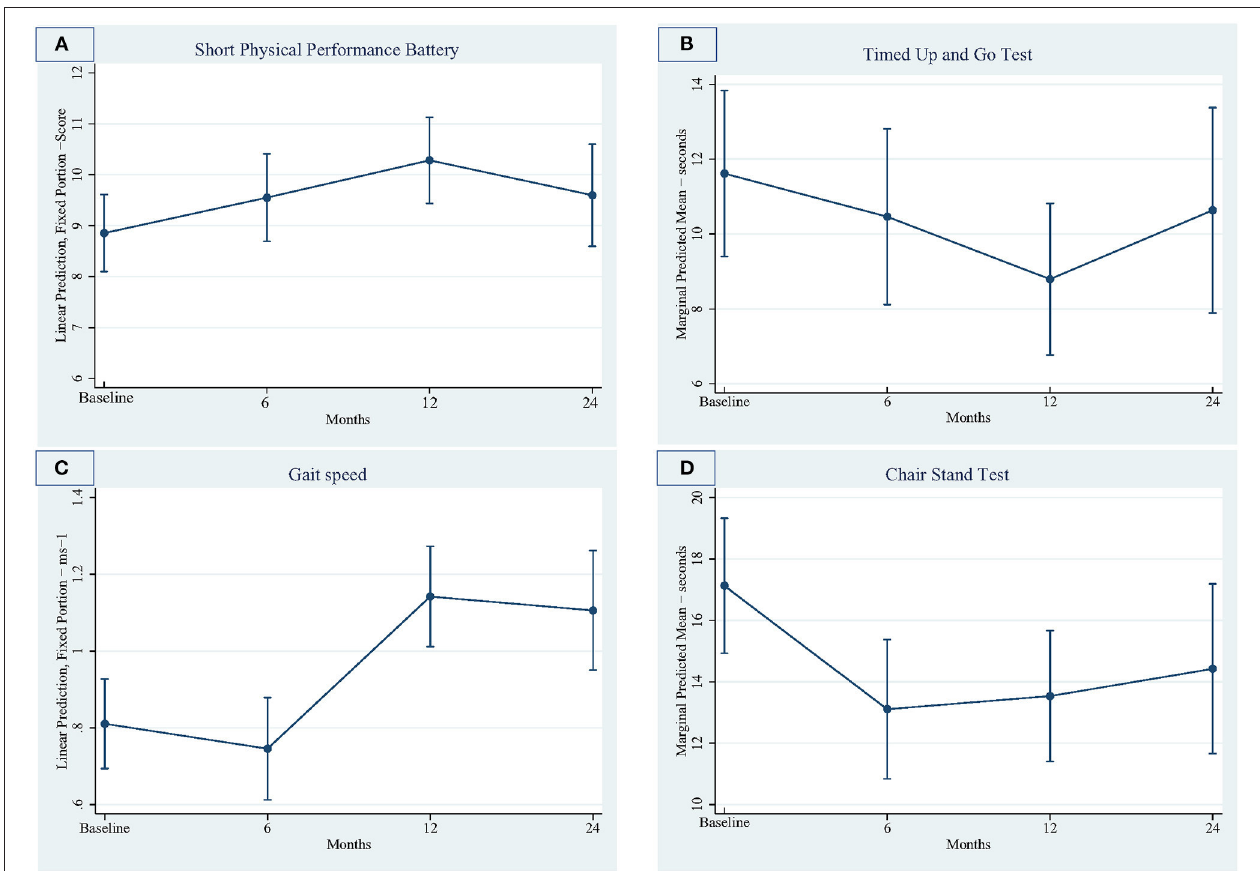
FIGURE 2 | Physical function outcomes over four timepoints. (A) Short physical performance battery, (B) Timed up and go test, (C) Gait speed, (D) Chair stand test.